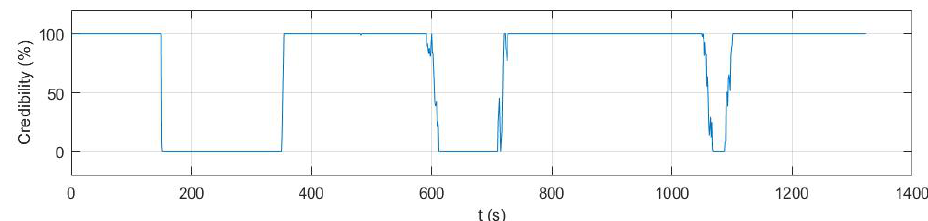
Figure 9. Credibility evaluation result of